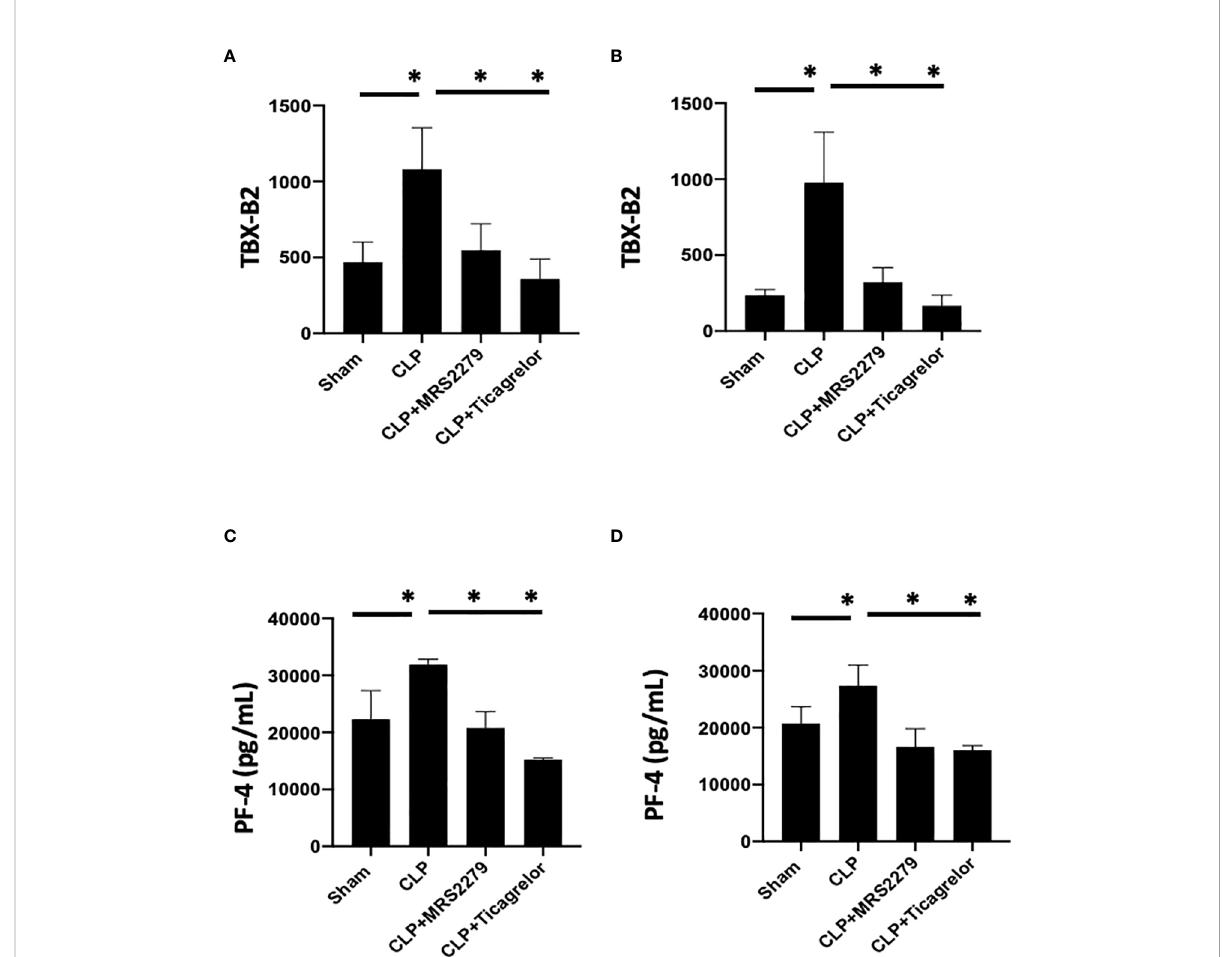
FIGURE 6 P2Y 12 or P2Y 1 antagonism decreased sepsis-induced platelet secretion in both male and female mice. Plasma levels of Thromboxane (TBX-B2) (A, B) or PF4 (C, D) were evaluated in female (left) and male (right) mice that underwent Sham or CLP surgery. Mice were treated with MRS2279 (MRS) or ticagrelor. Values are expressed as pmol/mL (*p < 0.05, n =